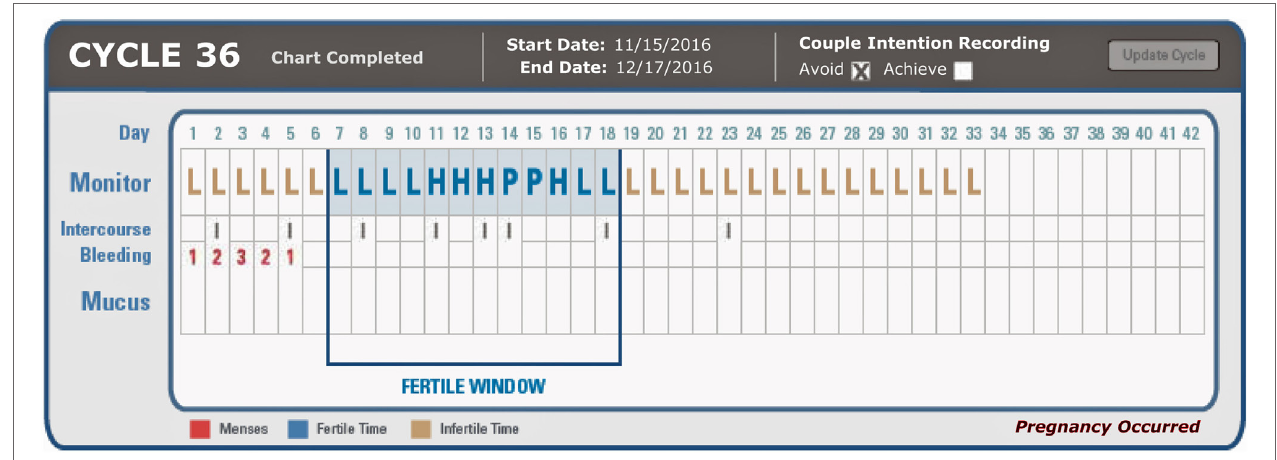
FigUre 1 | Example of online charting system indicating ClearBlue Fertility Monitor results (L/H/P for Low, High, Peak, respectively), intercourse frequency, bleeding (1 = light, 2 = moderate, 3 = heavy), and mucus findings (not recorded in this participant)